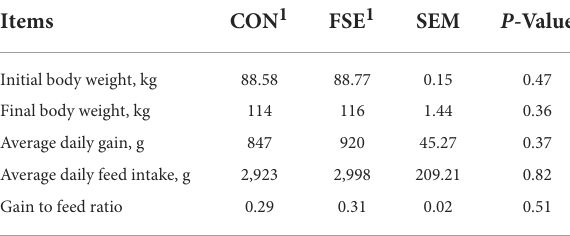
TABLE 2 Effect of Forsythia suspensa extract on the performance of finishing pigs.